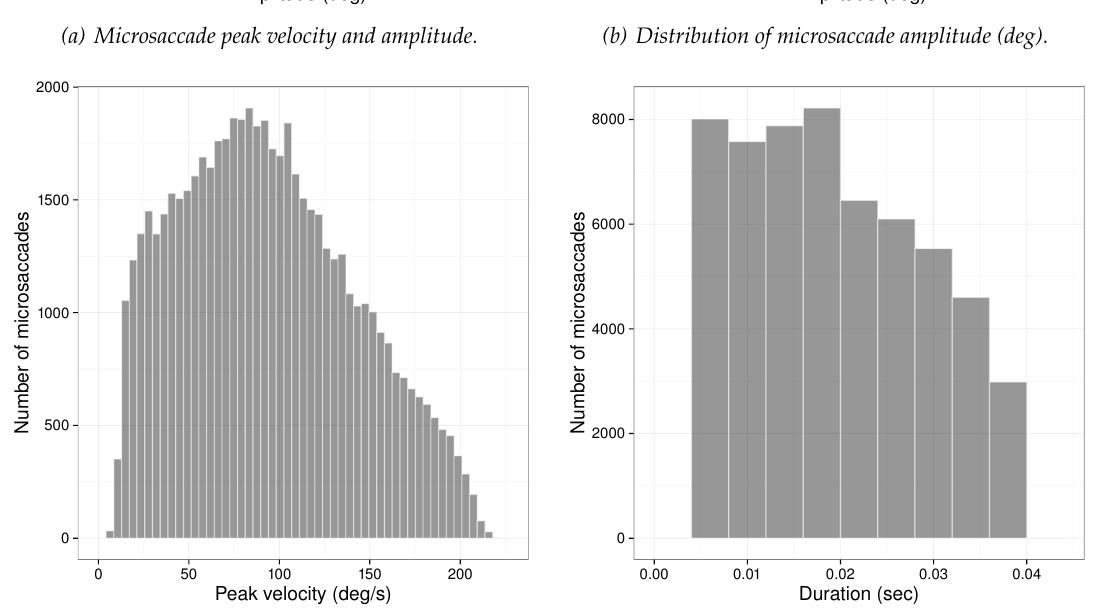
Figure 9 . Experiment 3. Distribution of microsaccade amplitude (b), peak velocity (c), and duration (d). Figure (a) depicts the nonlinear relationship between peak velocity and amplitude with different function fits. Data were captured at 500